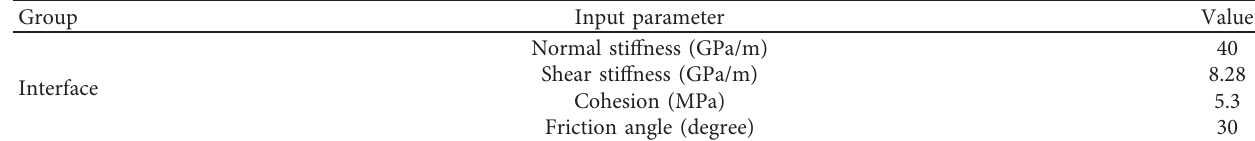
Table 3: Input parameters for the